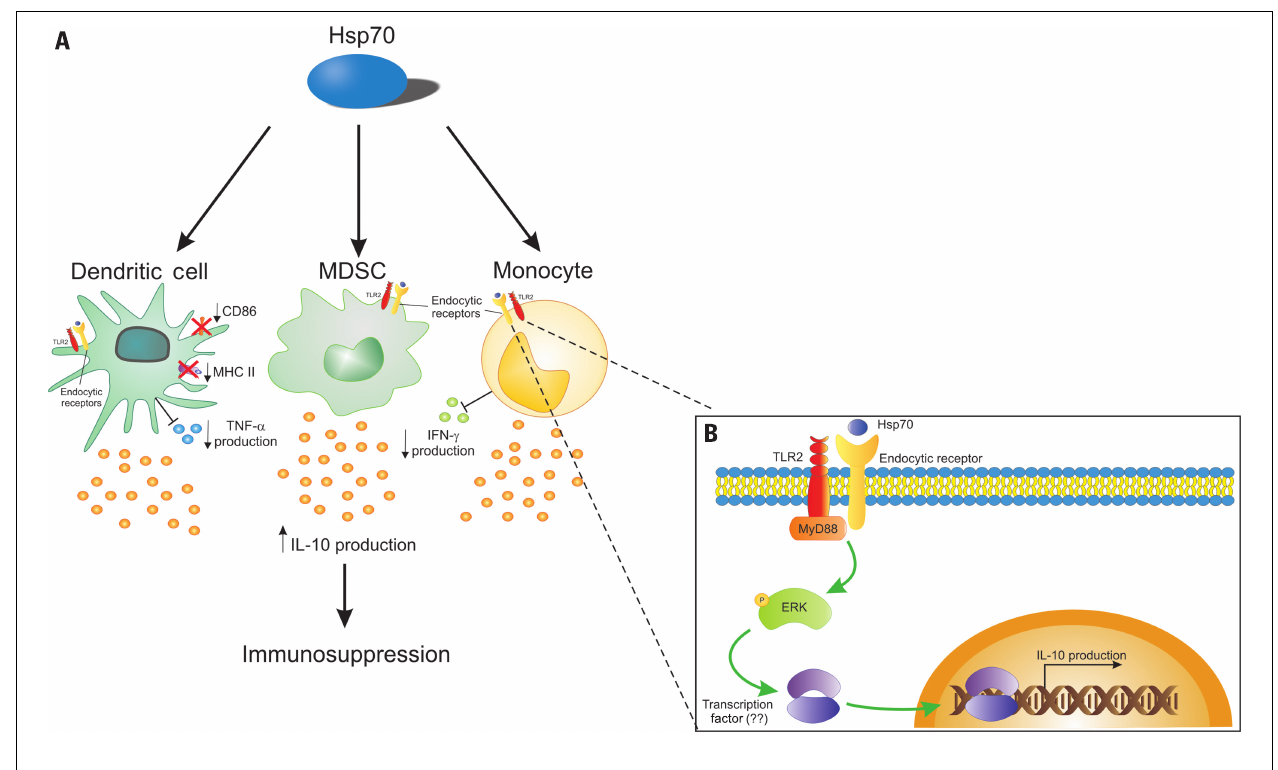
In DCs, Hsp70 downregulates CD86 and MHC class II expression, and inhibitsTNF- α production. Also, Hsp70 can inhibit IFN- γ by monocytes. (B) Upon binding to an endocytic, Hsp70 signals through TLR2, resulting in MyD88 activation.The subsequent phosphorylation of ERK can trigger the activation of an undetermined transcription factor that will bind the il-10 gene promoter leading to IL-10